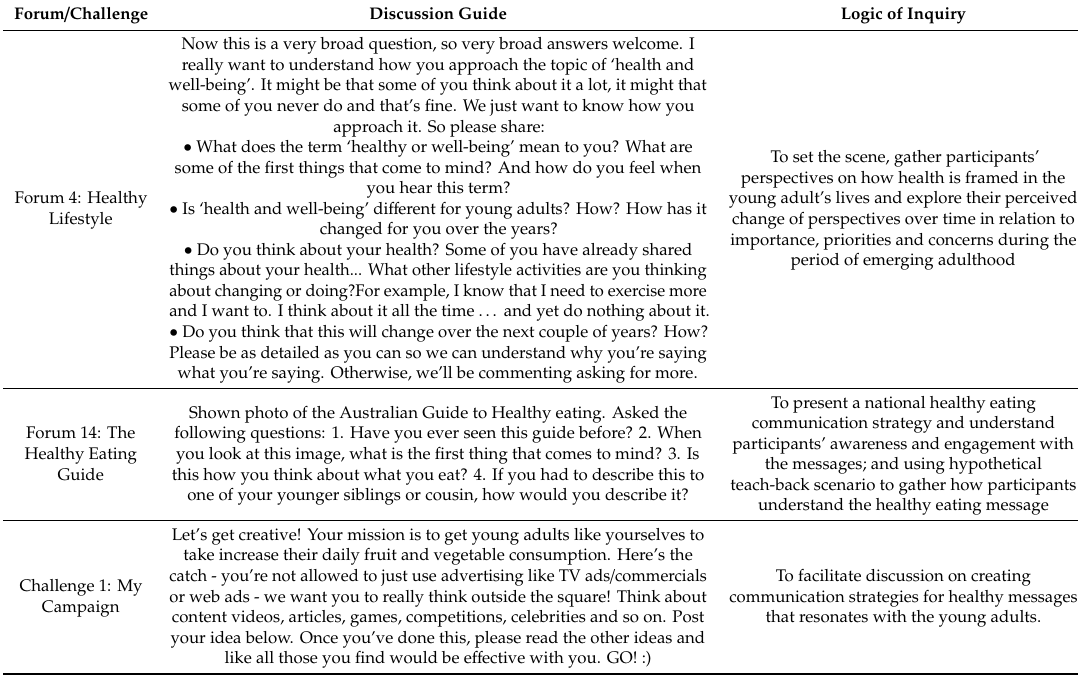
Table 1. Discussion Guide for the forums